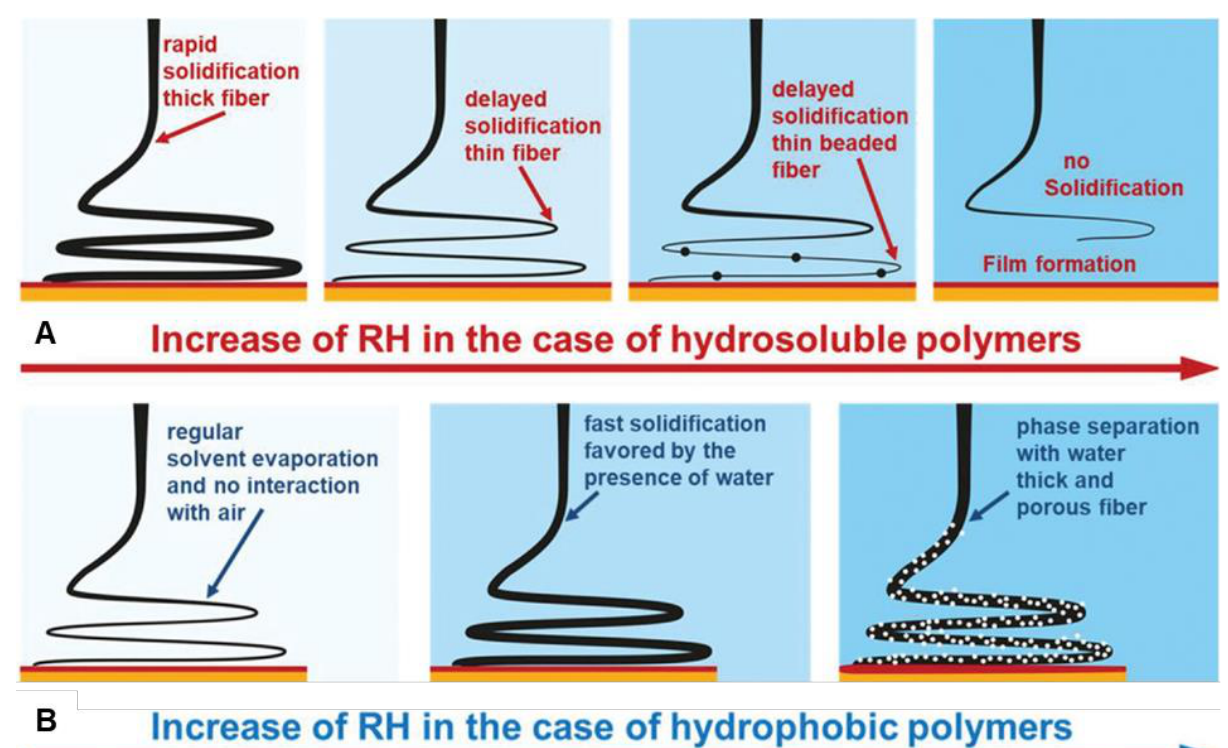
Figure 10. Effect of increasing relative humidity (RH) on ( A ) water-soluble and ( B ) hydrophobic electrospun polymers. Reprinted from [168]. Copyright 2021, John Wiley & Sons.